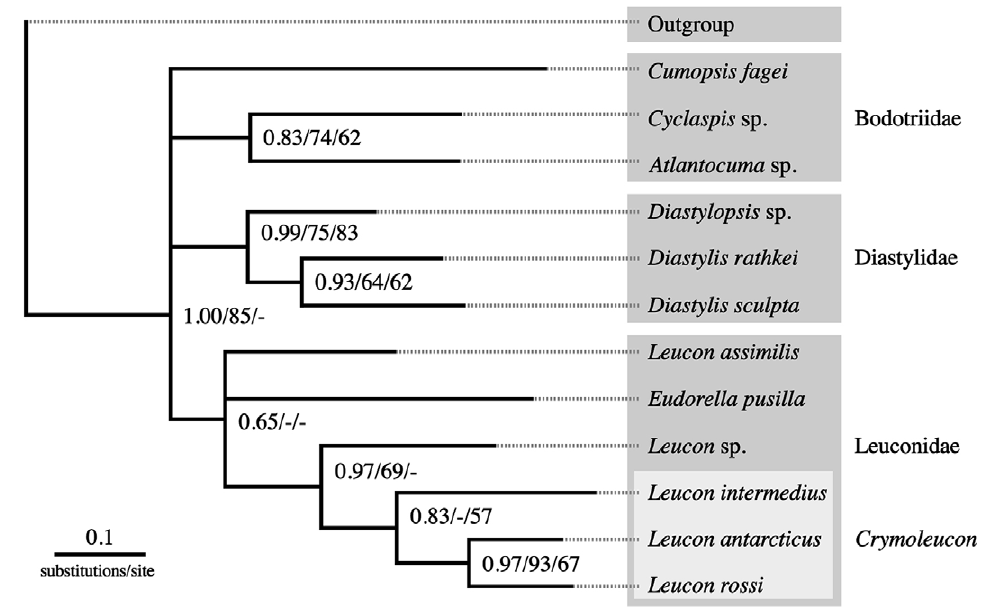
Fig. 1. – Bayesian analysis consensus tree (50% majority rule) based on 16S rDNA. The GTR+I+ Γ model was used according to the Akaike information criterion test. First numbers represent the portions of sampled trees, in which the corresponding node was found (posterior prob- ability). Second numbers and third numbers represent bootstrap values of maximum likelihood (1000 iterations) and maximum parsimony (10000 iterations) analysis, respectively (Outgroup taxa see Table 2). Values below 0.5 or 50 are not shown. Species are grouped by colour